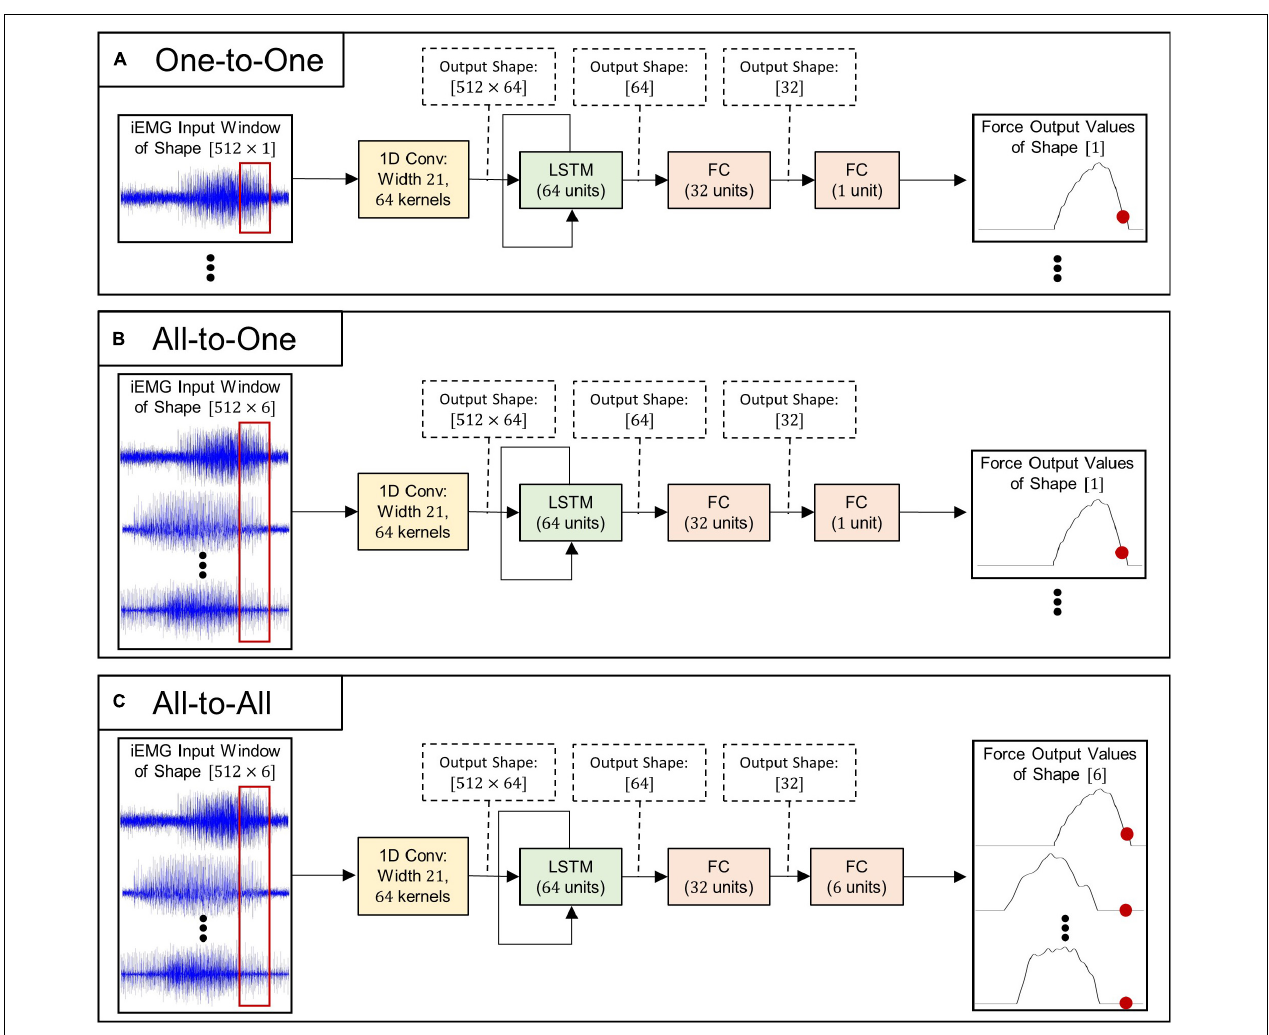
FIGURE 1 | Schematic illustrations of deep learning algorithms used for myoelectric force regression: (A) model architecture used for the One-to-One regression strategy, (B) model architecture used for the All-to-One regression strategy, and (C) model architecture used for the All-to-All regression strategy.